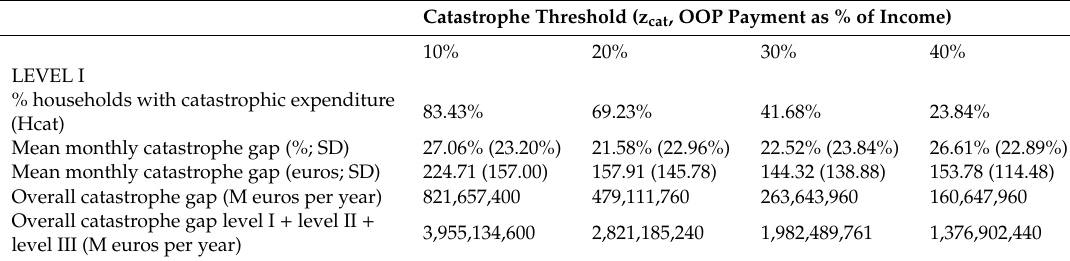
Table 9. Catastrophic e ff ect of dependent care OOP payments by level. Scenario 2 (complete application, including levels I, II, and